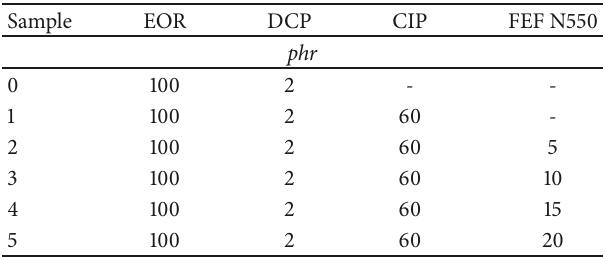
Table 1: Composition of elastomer